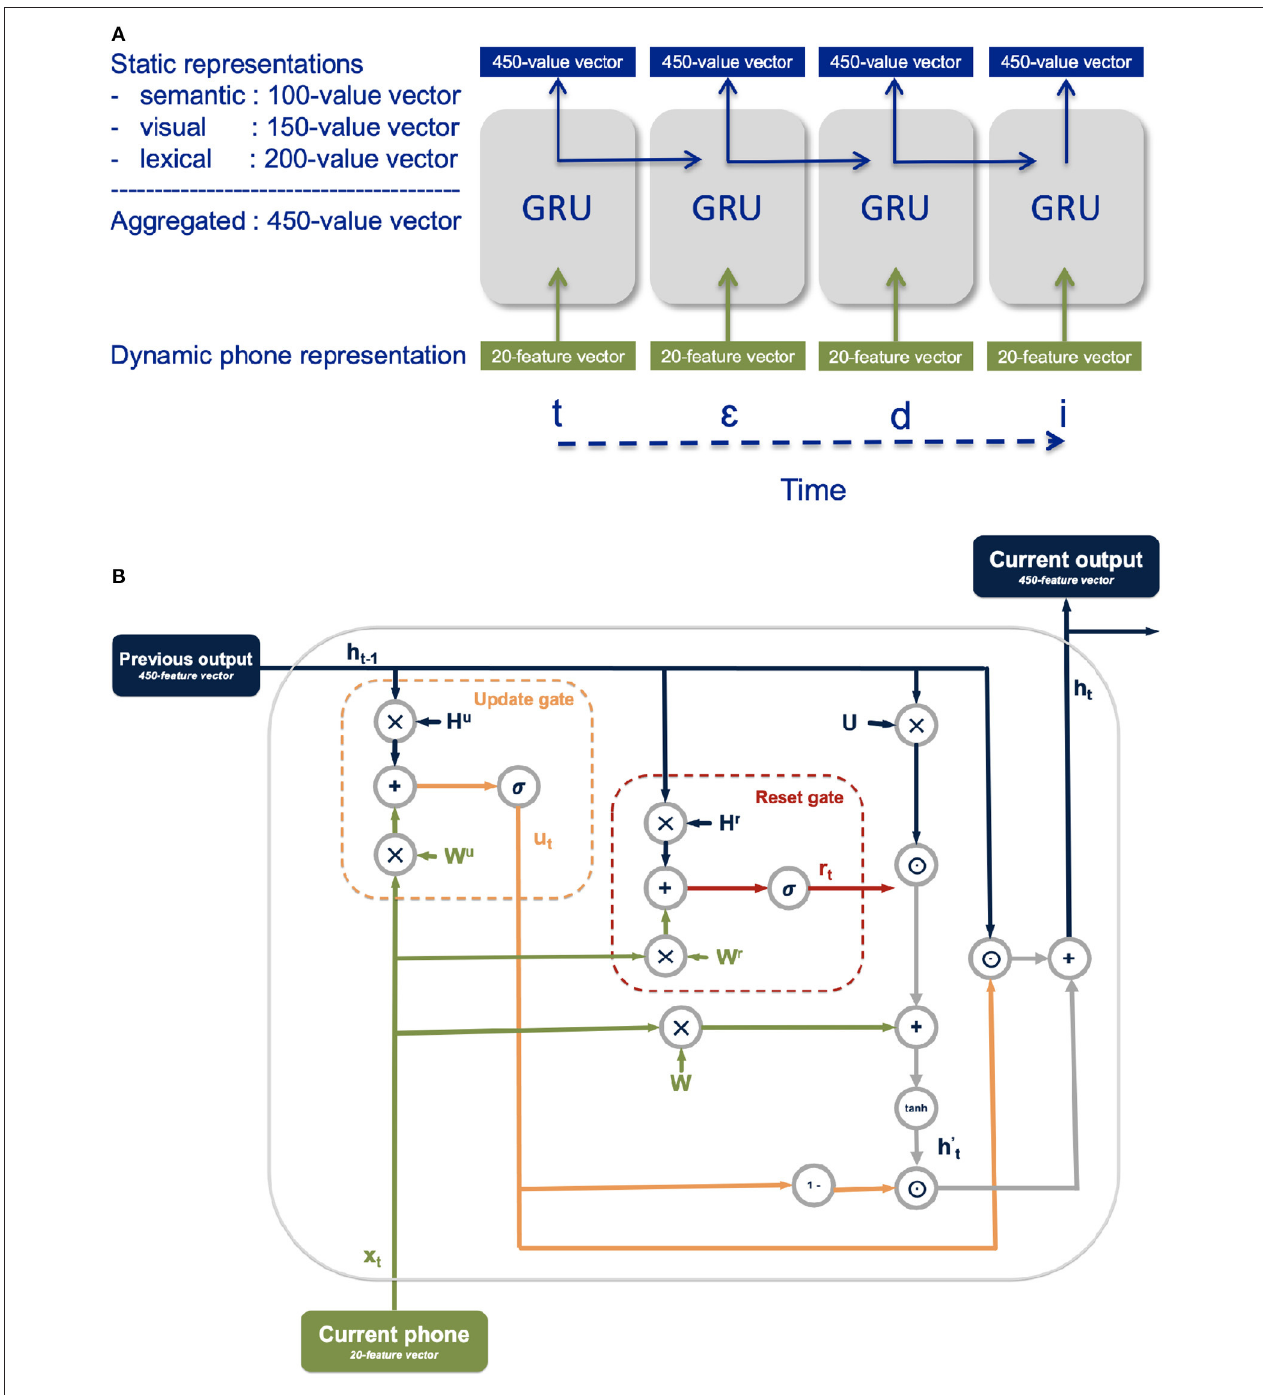
FIGURE 4 | (A) Illustration of the model activation at the unfolding of the word teddy ; intermediate co-articulation timesteps are suppressed in the graphic. (B) Detailed illustration of the GRU functionality.